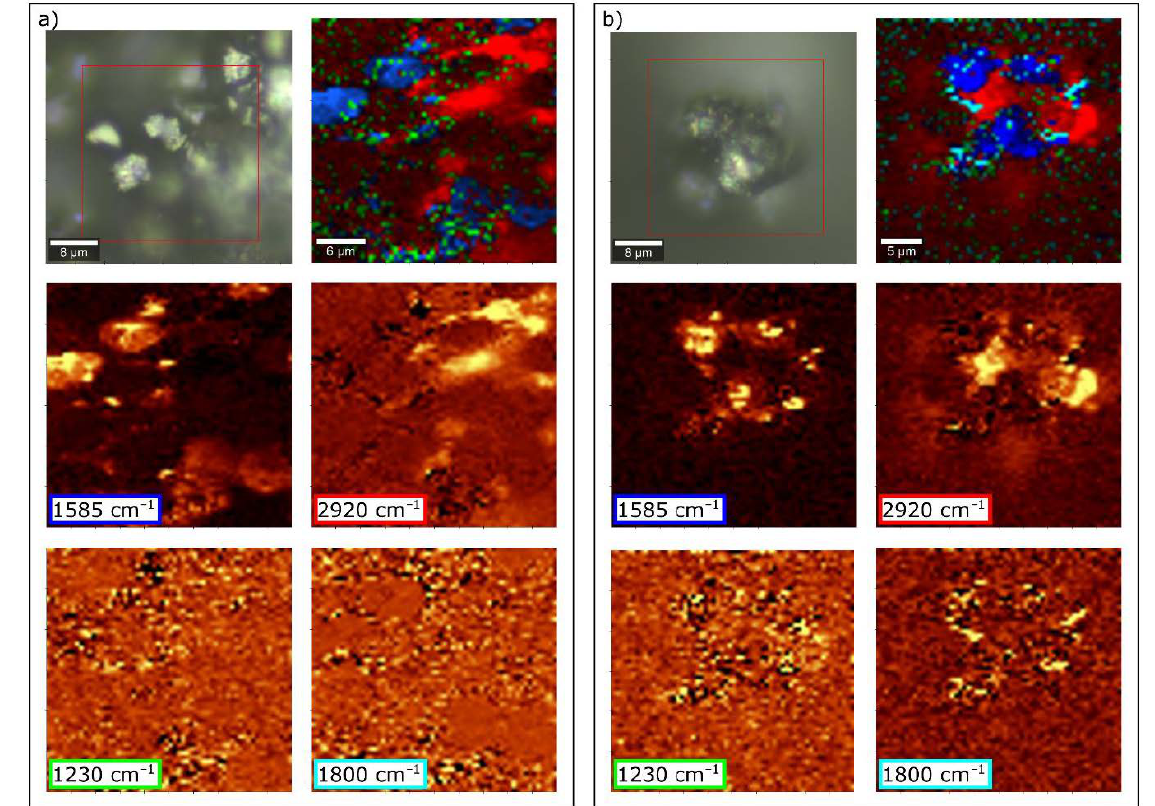
Figure 11. Raman images of ( a ) the reference CFRP composite and ( b ) the CFRP sample with 0.3% GO